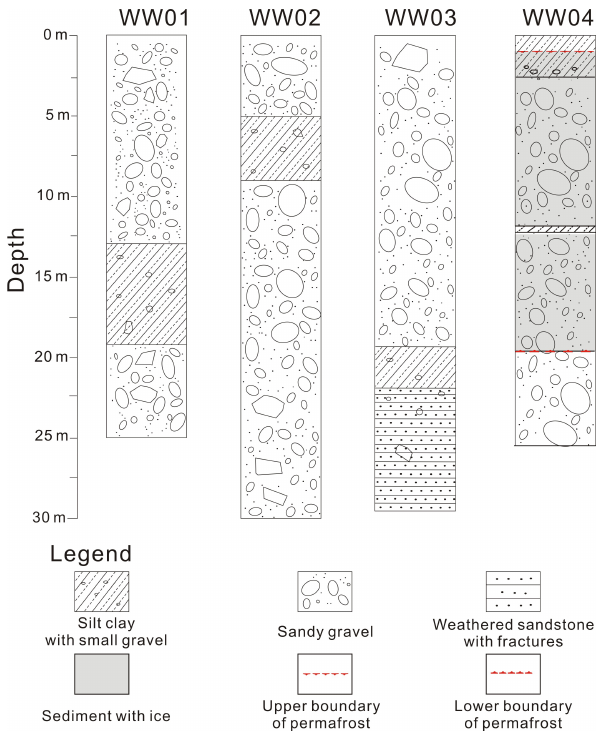
Figure 3. The well logs of the sediments for clusters WW01, WW02 and WW03 within the seasonal frost zone, as well as cluster WW04 within the permafrost